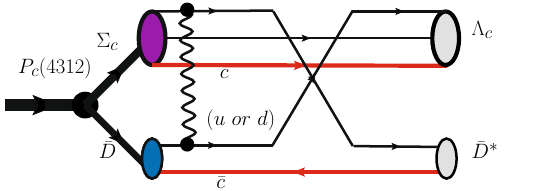
Fig. 2 Schematic diagrams for the open charm decay P c ((cid:2) c + ¯ D ) → (cid:3) + ¯ D ∗ withthequarkre-arrangementbetweenthe1-stand4-thquarks. c There are two types of interaction: One of them (left sub-diagram) is characterized by the interaction occurs between two quarks which par- ticipate in the quark-exchange at the same time. The other type (right